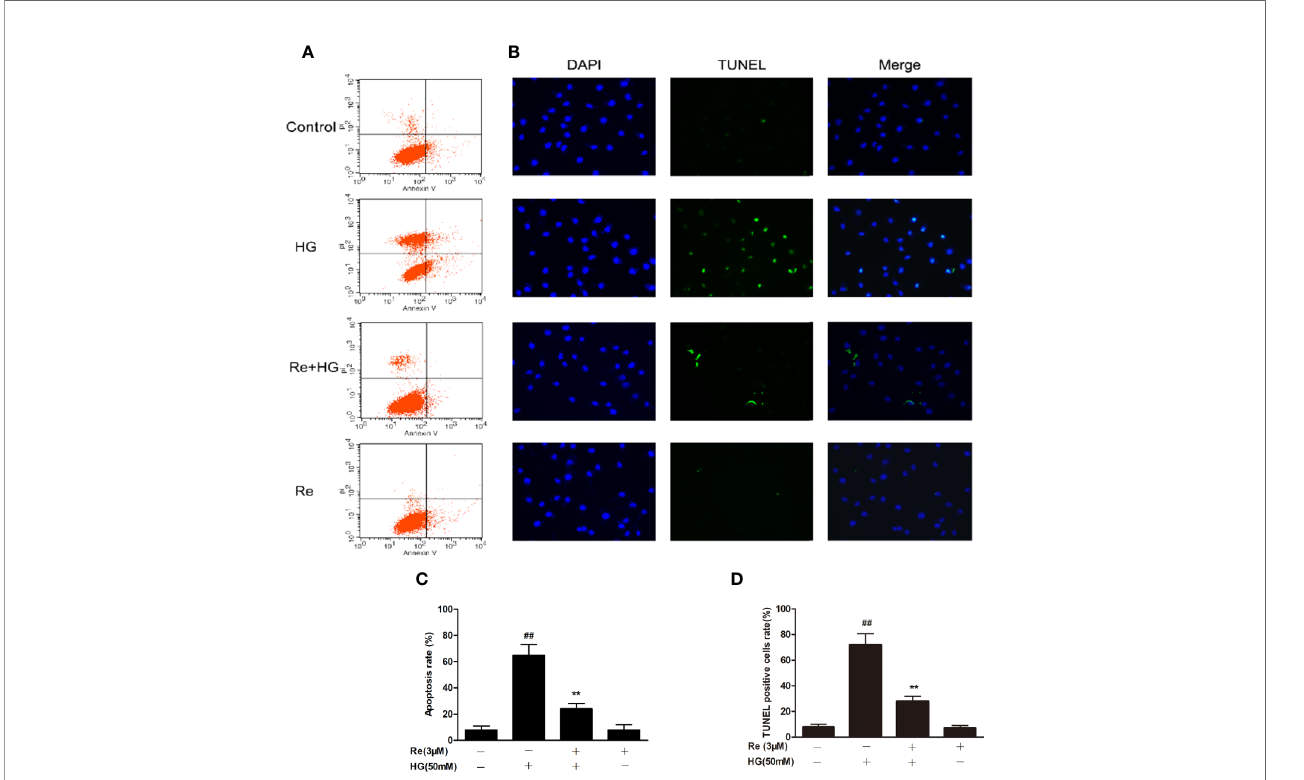
FIGURE 5 | Effects of Ginsenoside Re on HG-triggered apoptosis in RF/6A cells. (A) Distribution map of apoptotic cells detected by annexin V/PI double staining. (B) Representative images captured with fl uorescence microscopy showing TUNEL-stained RF/6A cells. (C) Quantitative analysis of the ratio of annexin V/PI-positive cells to total cells. (D) The ratio of TUNEL-positive cells. The results are expressed as the mean ± SE of the mean (n = 5). ## P < 0.01 versus the control group; **P < 0.01 versus the HG group. Scale bar, 50 m